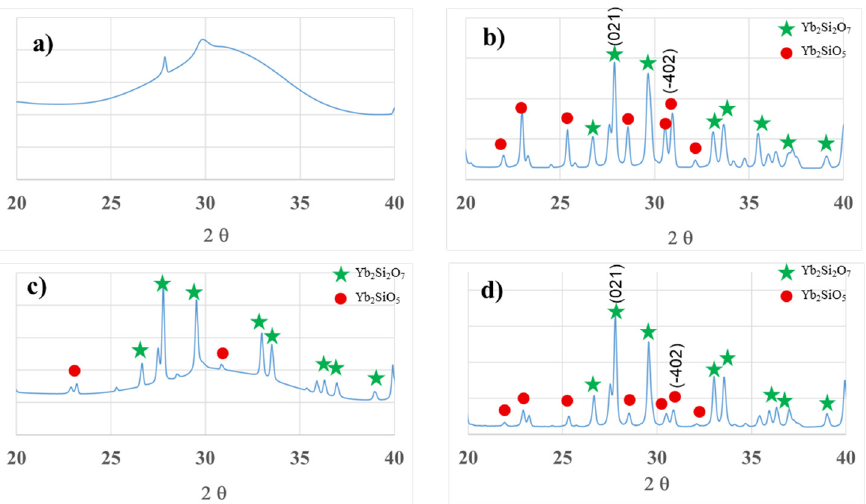
Figure 2. XRD patterns of APS and LPPS coatings. ( a ) As-sprayed APS coating; ( b ) 1300 °C/10 h heat treated APS coating; ( c ) as-sprayed LPPS coating; ( d ) 1300 °C/10 h heat treated LPPS